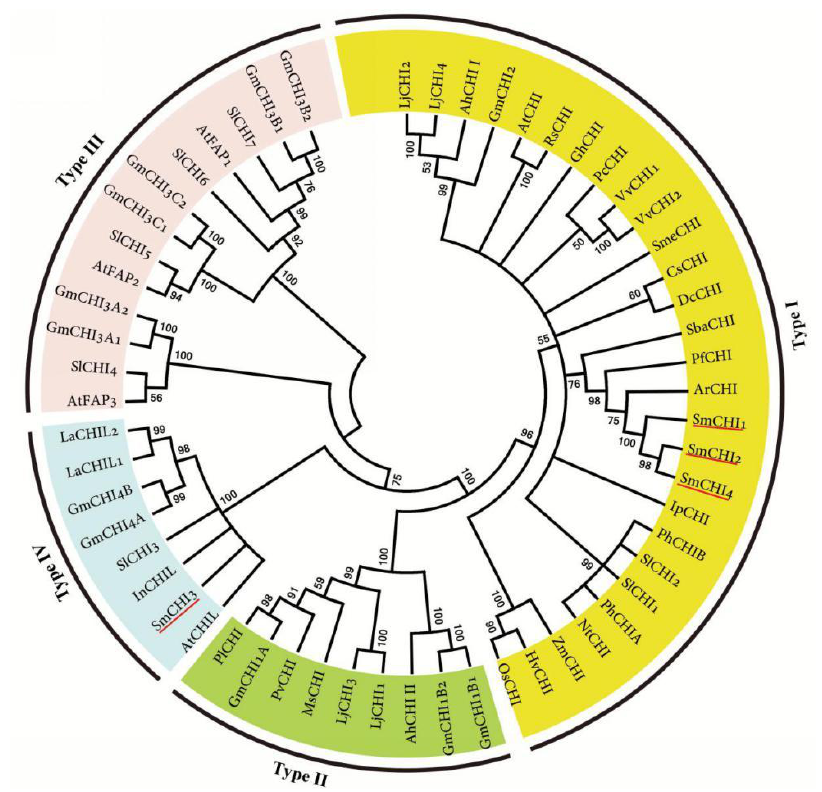
Figure 4. The phylogenetic relationship of CHI proteins. The numbers represent the bootstrap values. These CHI protein sequences used for phlogenetic analysis were retrieved from NCBI and their accession numbers are listed in Supplementary Table S5.